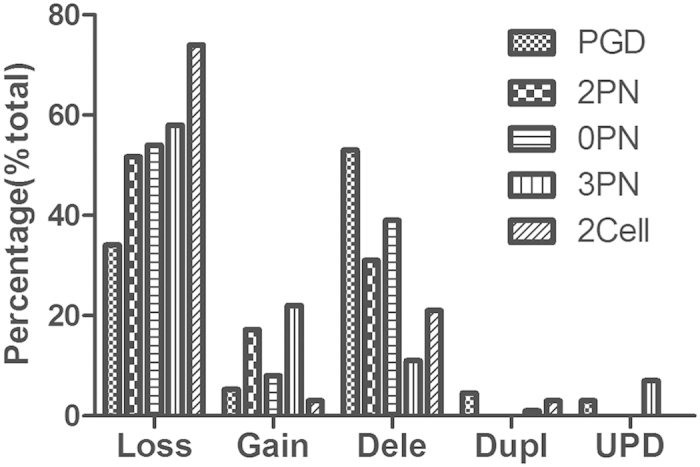
SNP array-based chromosome analysis of blastocysts from clinical PGD samples and discarded embryos.Frequently-detected abnormal signals following SNP microarray analysis were analyzed by dividing the number of distinct signals by the number of abnormal signals. “PGD” refers to data from PGD patients. These data were compared with data generated from blastocysts derived from 2PN-, 0PN-, 3PN-, and 2Cell-derived embryos; other abbreviations are as for Fig. 2.